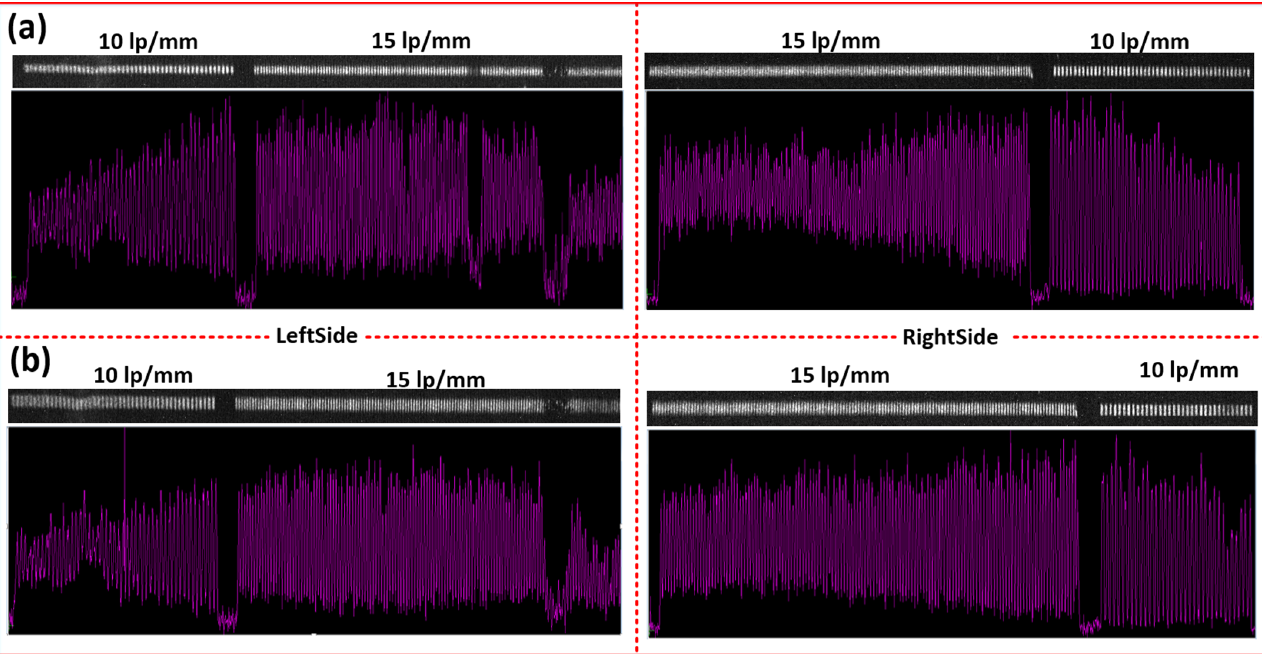
Figure 4. Experimental test results of different tube lengths; the upper part is the streak image, and